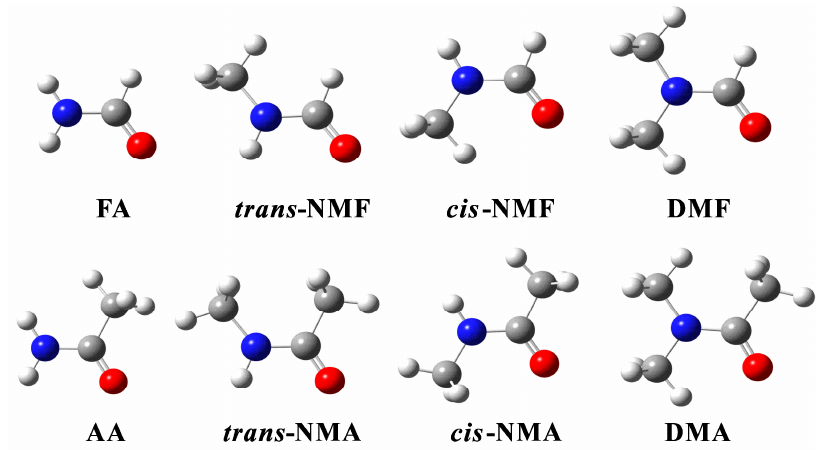
Figure 1. The stable structures of the monomers obtained at the B3LYP-D3/aug-cc-pVTZ level; FA: formamide; NMF: N -methylformamide; DMF: N , N -dimethylformamide; AA: acetamide; NMA: N -methylacetamide; DMA: N , N -dimethylacetamide.